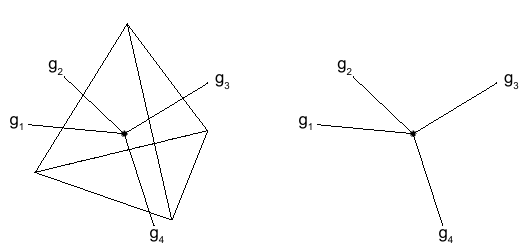
, . . . , g ) ∈ L 2 ( G d /G ) for the case d = 4 . On the left, the 1 d